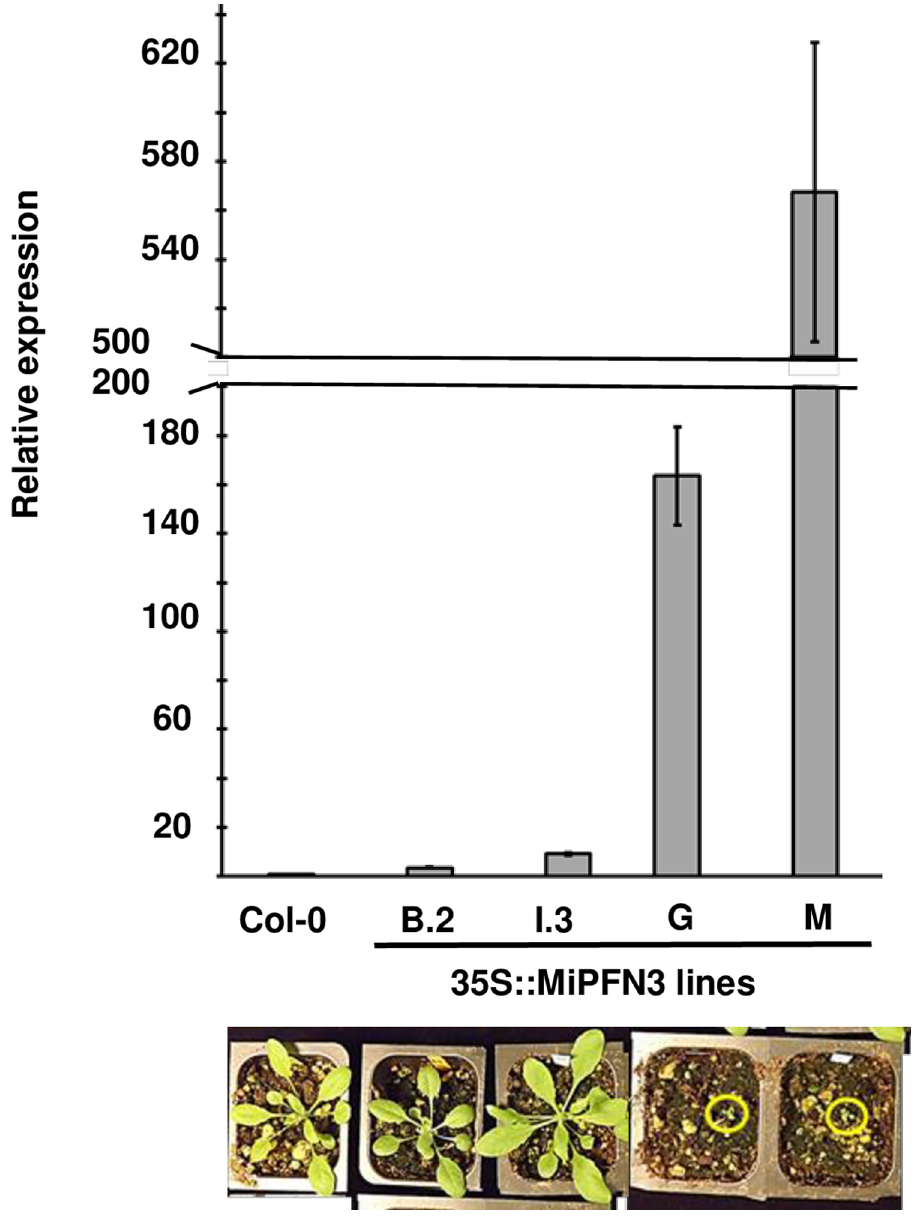
Fig 4. Correlation between MiPFN3 expression in Arabidopsis and growth phenotype. (A) The relative expression of MiPFN3 in Col-0 and the transgenic Arabidopsis lines B.2, I.3, G and M as determined by qRT-PCR. AtUBQ5 was used as the reference gene. Bar represents mean of three biological replicates +/- sem. (B) Photos of 24 day old plants of Col-0 and transgenic Arabidopsis lines grown in soil. Circles indicate location of dwarf plants.